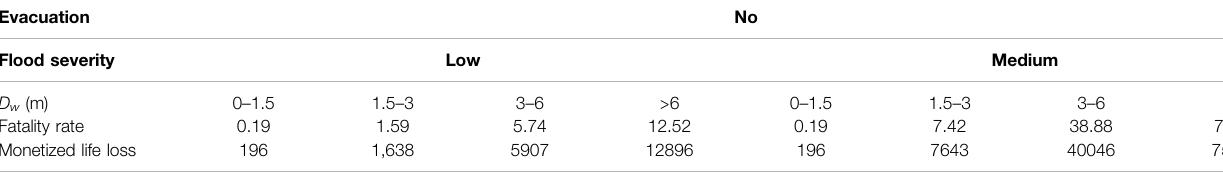
TABLE 4 | Prior probability of life loss with P ar of 1,000 based on Peng and Zhang (2013a). Evacuation No Flood severity